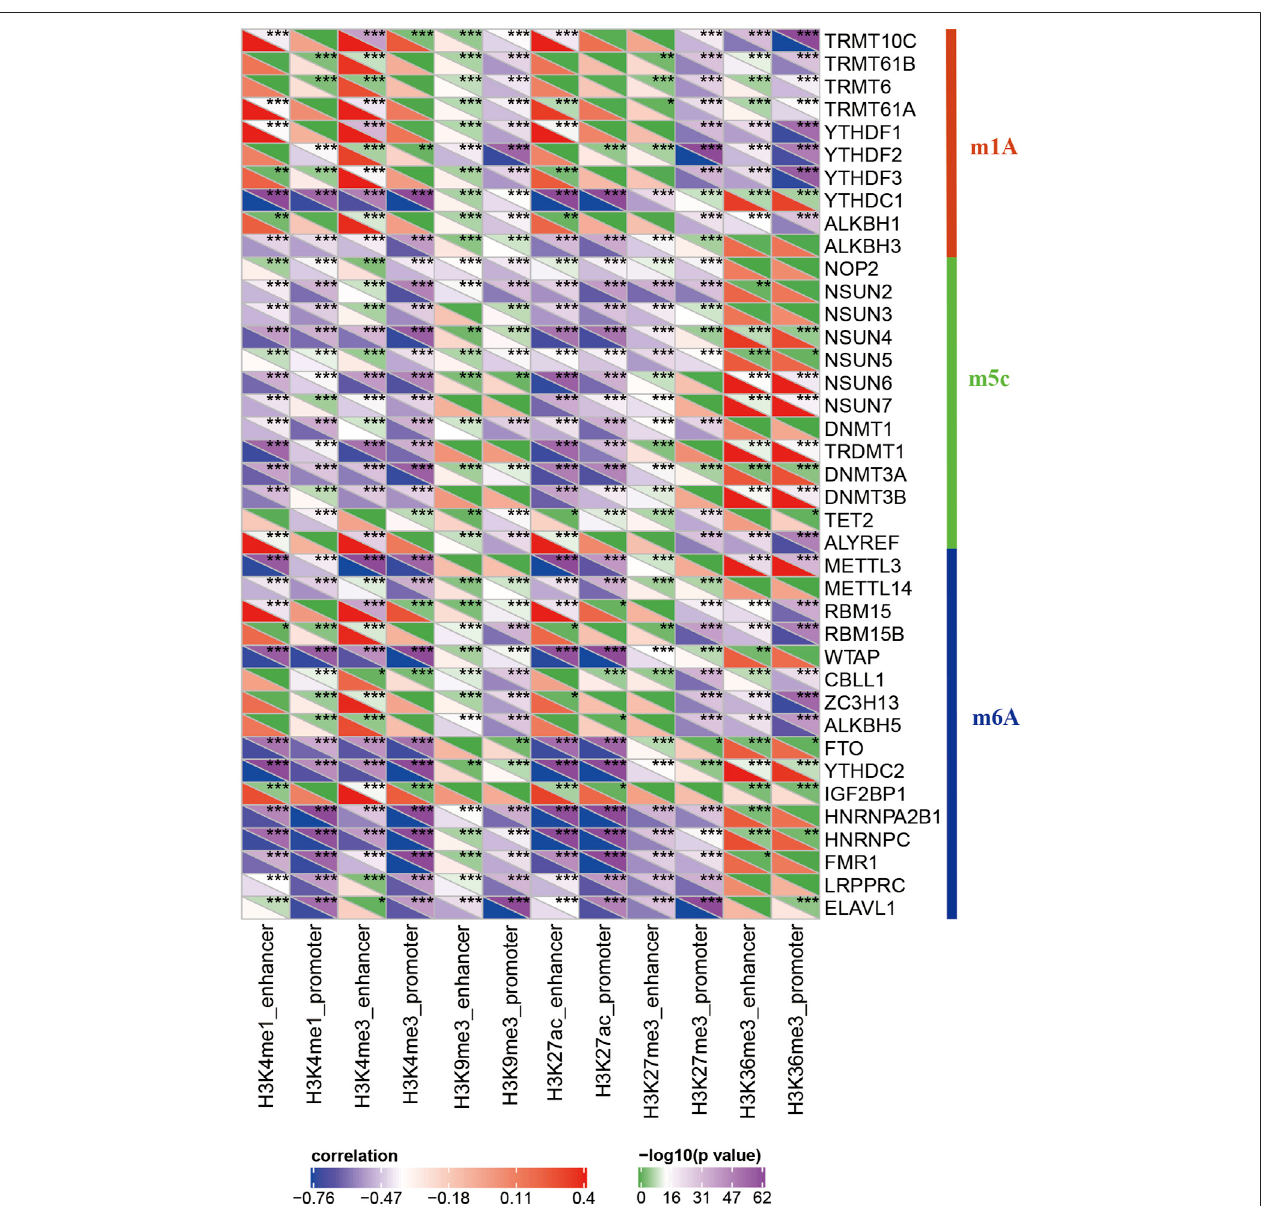
FIGURE 4 | Correlation between enrichment scores of 12 epi-lncRNAs and m6A-, m5C-, and m1A-related genes.